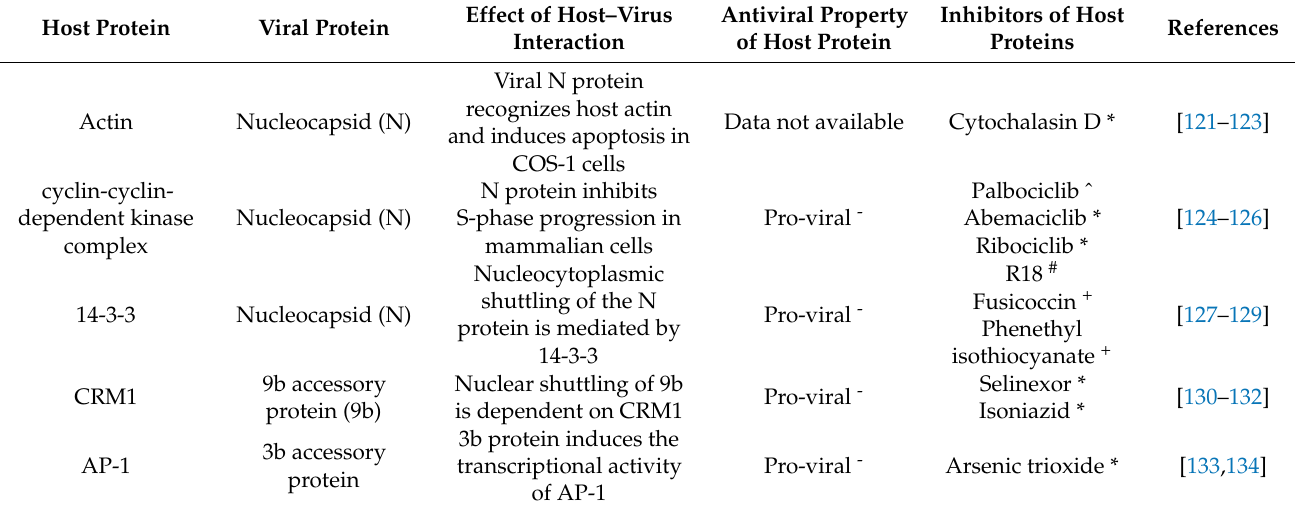
Table 4. SARS-CoV–host protein–protein interaction partners and their implications in the SARS-CoV life cycle. Host